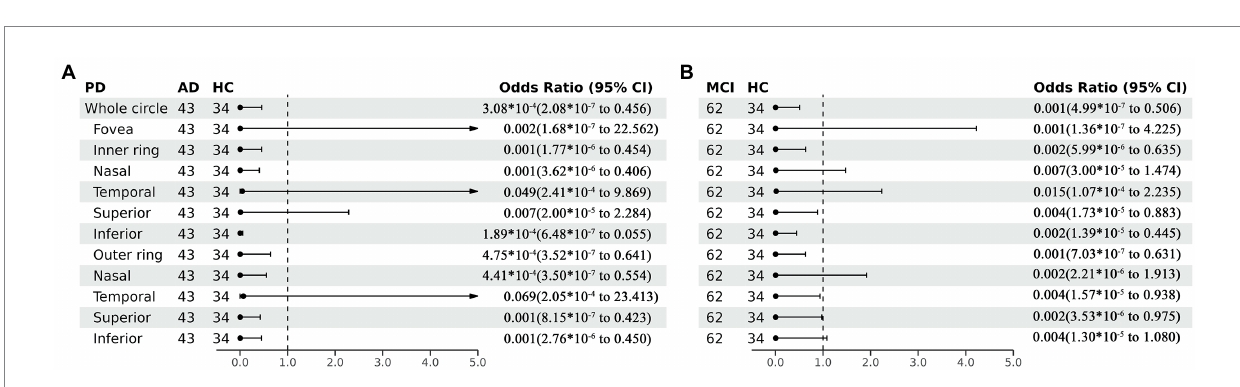
FIGURE 7 Forest plot of perfusion density comparison among three groups. Multiple logistic regression was used to assess the association between retinal perfusion density and clinical diagnosis, adjusted for confounders of sex, age, history of smoking, history of alcohol intake, hypertension, hyperlipidemia, BCVA, and IOP. (A) Compared with HC group, perfusion density decreased significantly in the nasal and inferior regions of the inner ring and in the nasal, superior and inferior regions of the outer ring in the AD group. (B) Compared with HC group, perfusion density decreased significantly in the superior and inferior regions of the inner ring and in the temporal and superior regions of the outer ring in the MCI group. PD, perfusion density; AD, Alzheimer’s disease; MCI, mental cognitive impairment; HC, healthy controls; CI, confidence interval.